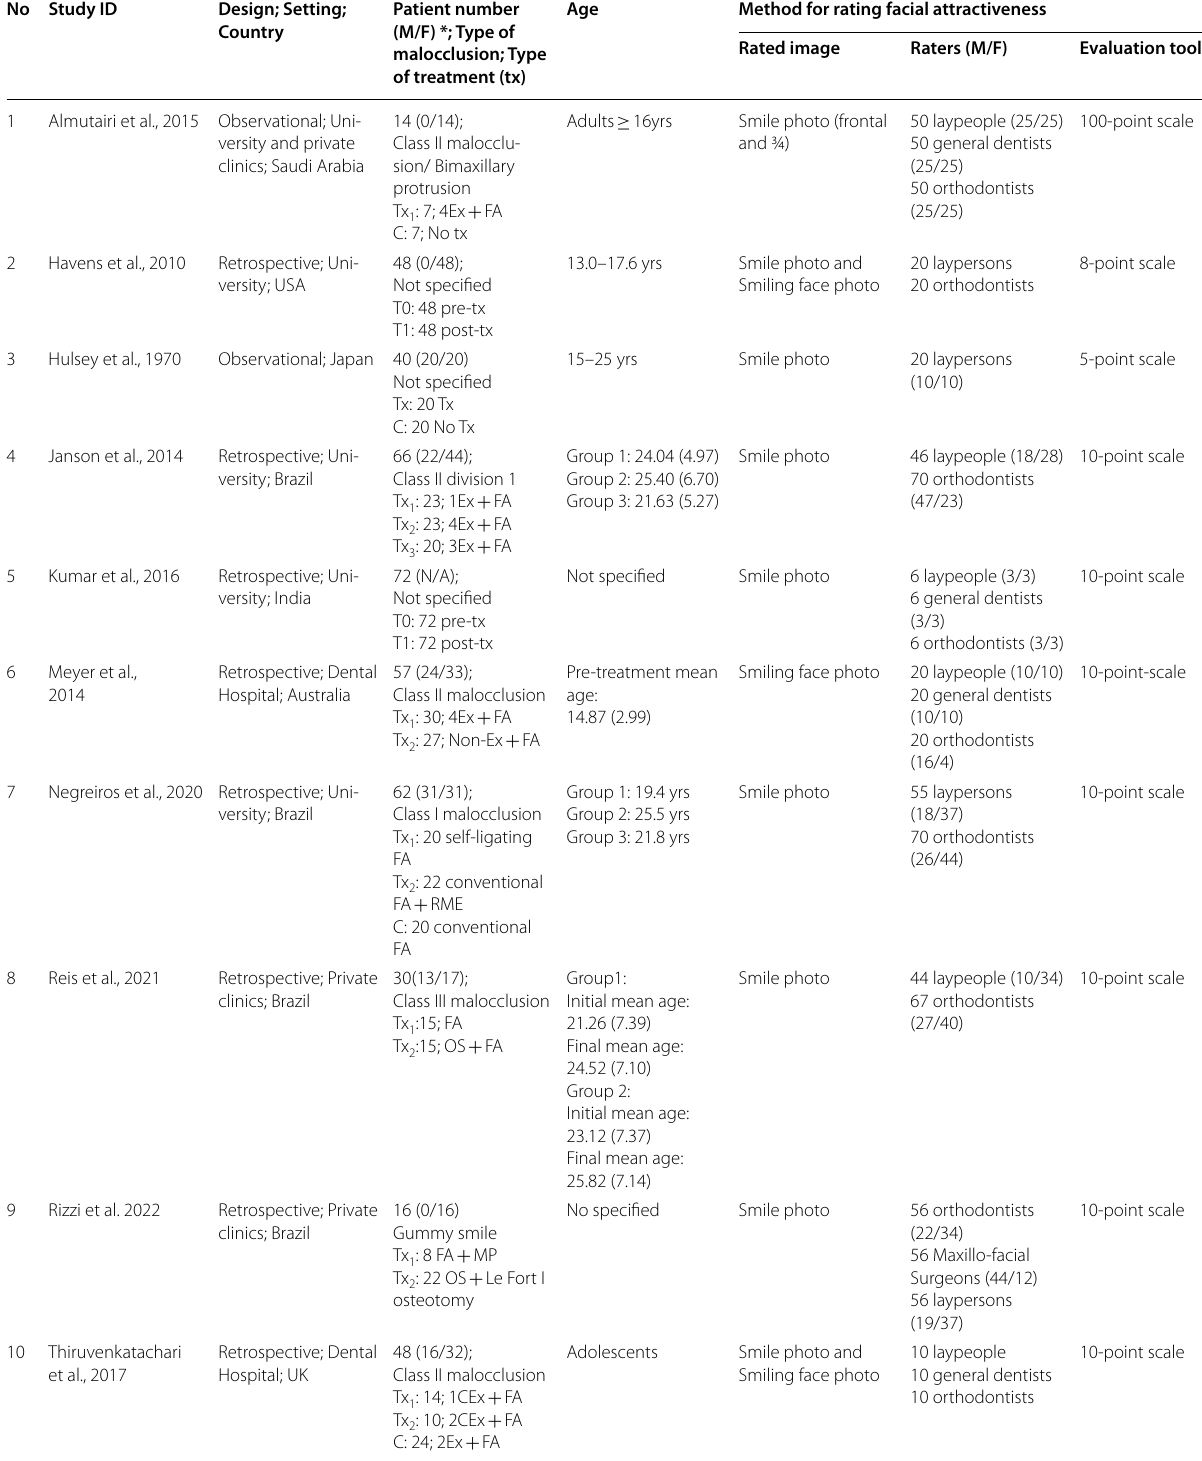
Table 2 Characteristics of included